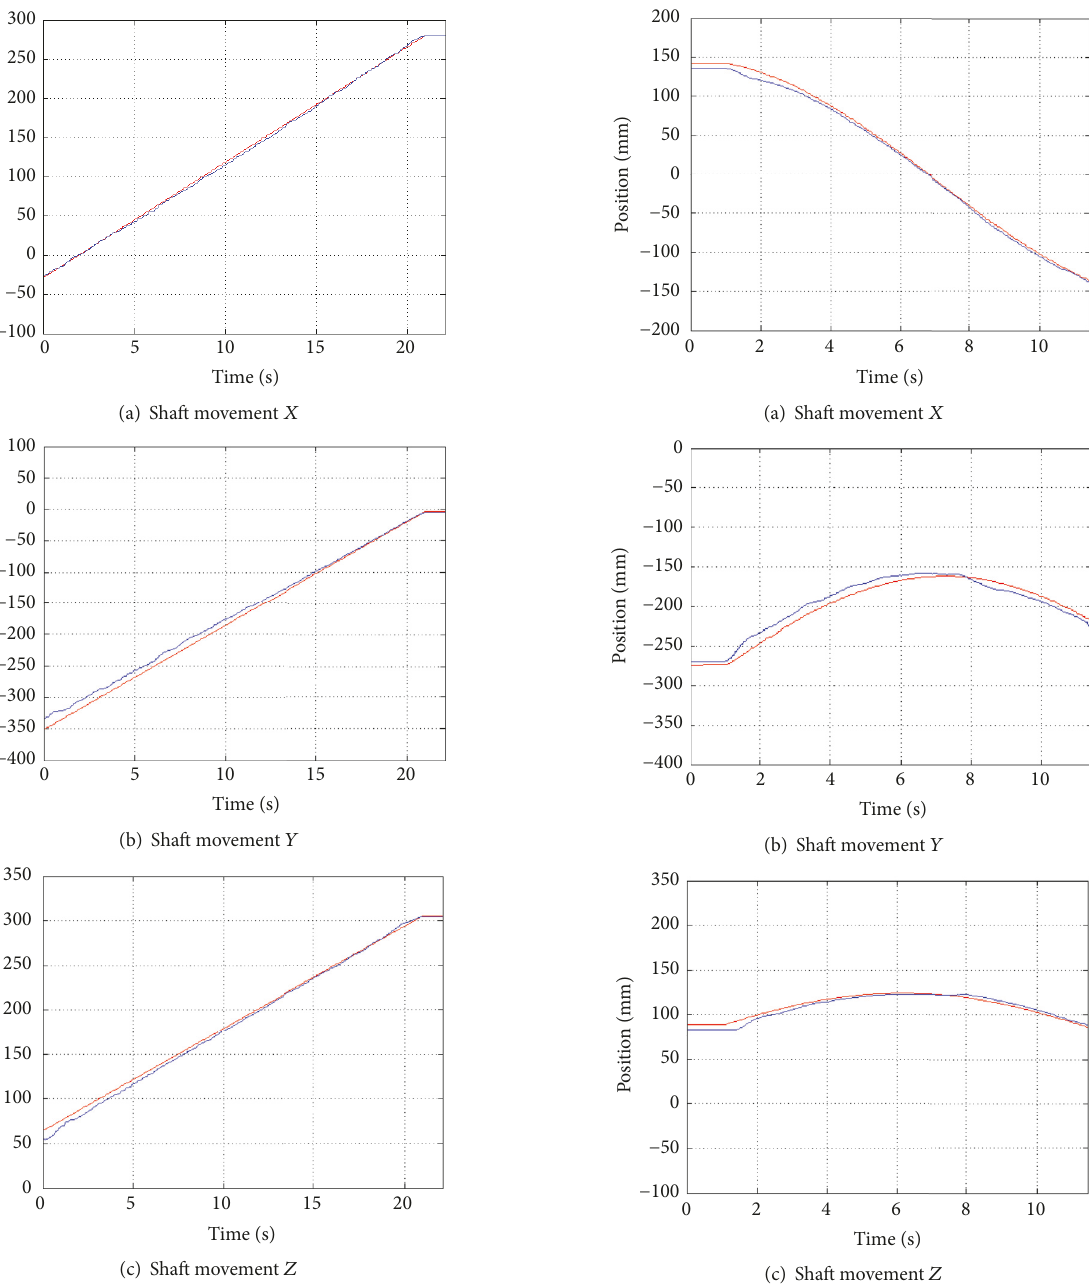
(articular, linear, and circular). For the interpolations of trajectories in Cartesian space (MOVES and MOVEC), it is necessary to calculate the IKM to find the articular values of each interpolated Cartesian point, which implies that it requires more processing in these commands, compared to MOVEJ.